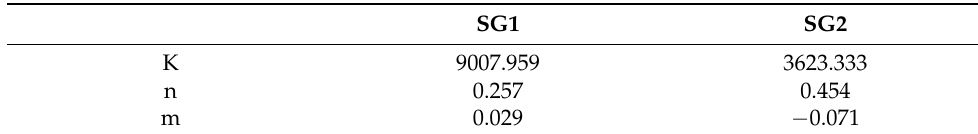
Table 3. Regression coefficients of Uzan model for subgrade materials.